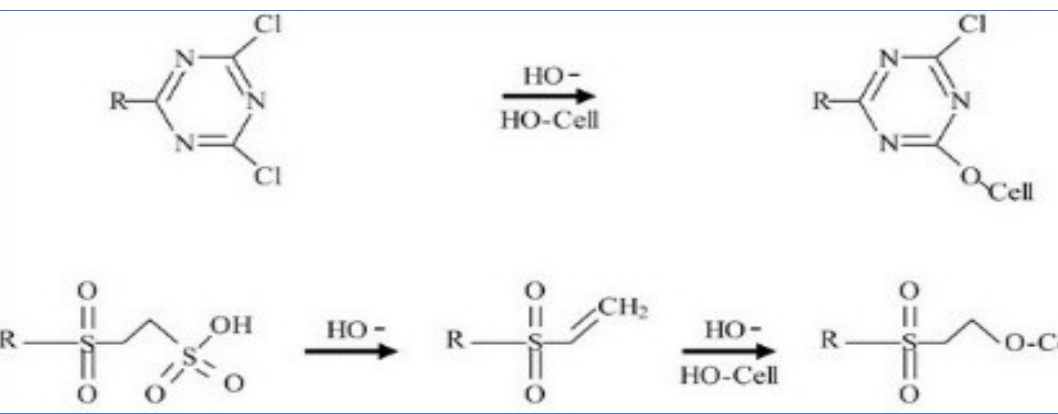
Figure 3. Typical mechanisms for dyeing cellulose.